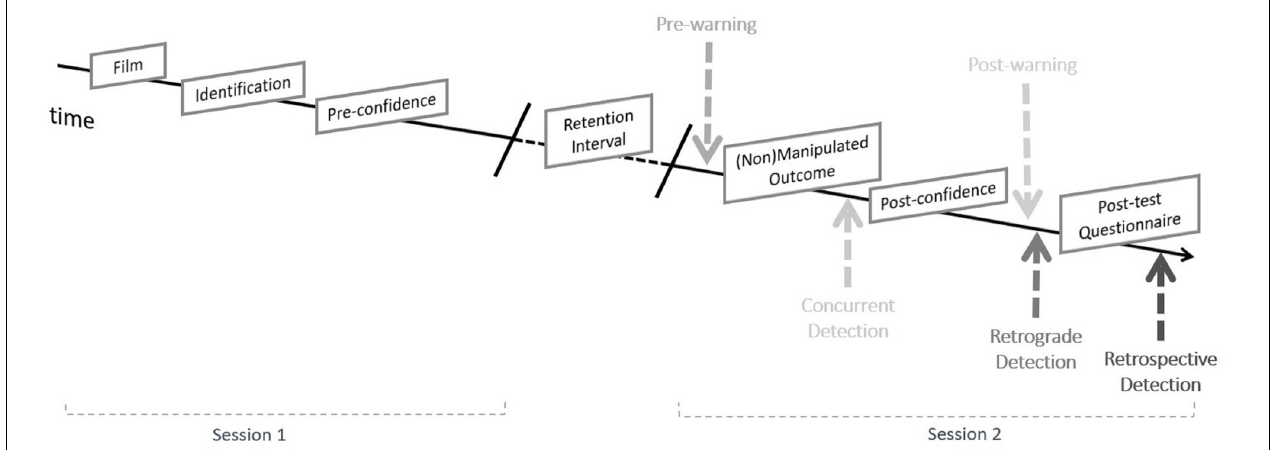
FIGURE 1 | Overview of the experimental procedure along with the point in time detections were recorded. Participants received only one warning (pre or post). Detections rates were measured at three points in time across all